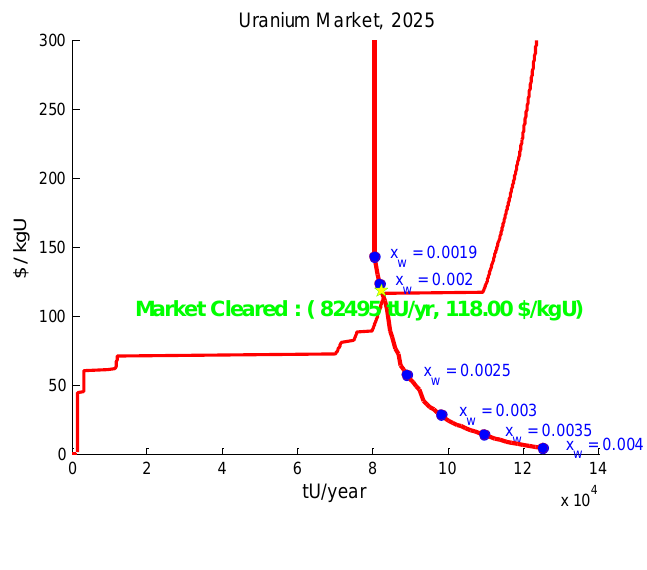
Figure 13. Uranium market supply and demand curves in